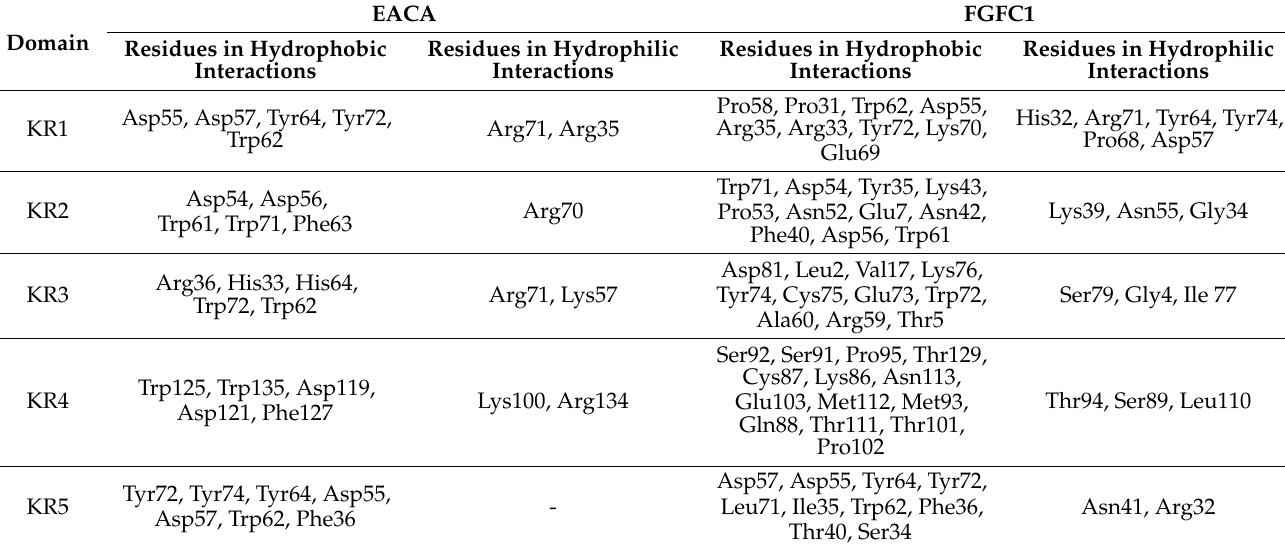
The binding affinity values for the most appropriate binding modes are shown in Table 3. The values obtained for EACA to KR1–KR5 were − 5.2, − 4.3, − 3.7, − 4.5, and − 4.3 kcal/mol, respectively, whereas those for FGFC1 to KR1–KR5 were − 7.4, − 9.0, − 6.3, − 8.3, and − 6.7 kcal/moL, respectively. The docking results showed that both EACA and FGFC1 bound to KR1–KR5 with moderately high binding affinity. In general, the binding affinity of FGFC1 to KR1–KR5 was stronger than that of EACA. These results